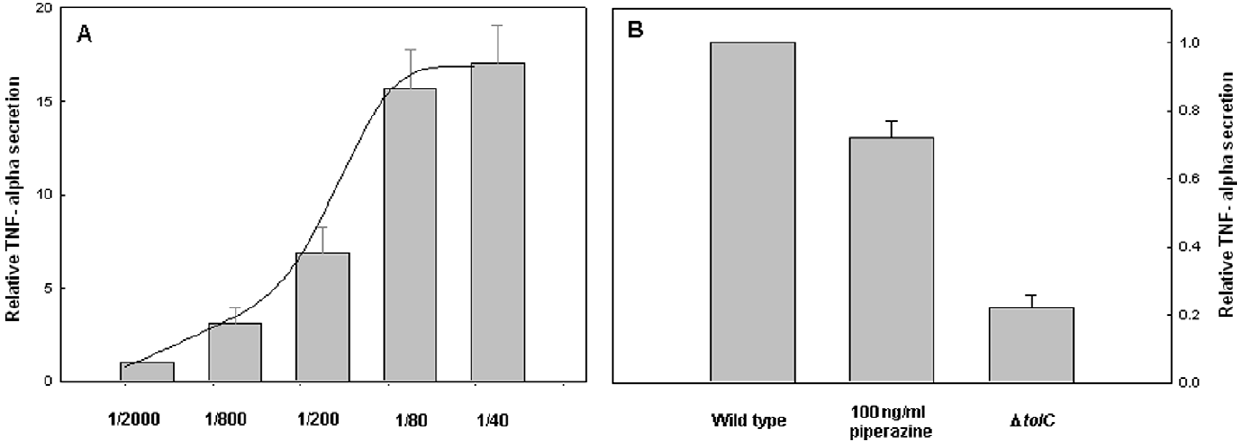
Figure 4. Effect of extracellular AGEs on secretion of TNF-alpha by THP-1 cells. The levels of TNF-alpha secreted by THP-1 cells were measured using sandwich-ELISA (see methods). A) TNF-alpha levels following exposure to elevated concentration of AGEs-containing fraction. B) Relative TNF-alpha levels secreted from THP-1 cells following exposure to the extracellular fractions (1/80 stock dilutions in distilled water) secreted from wild type cells, peprazine-treated cells and D tolc mutant cells. The data represent three independent experiments.